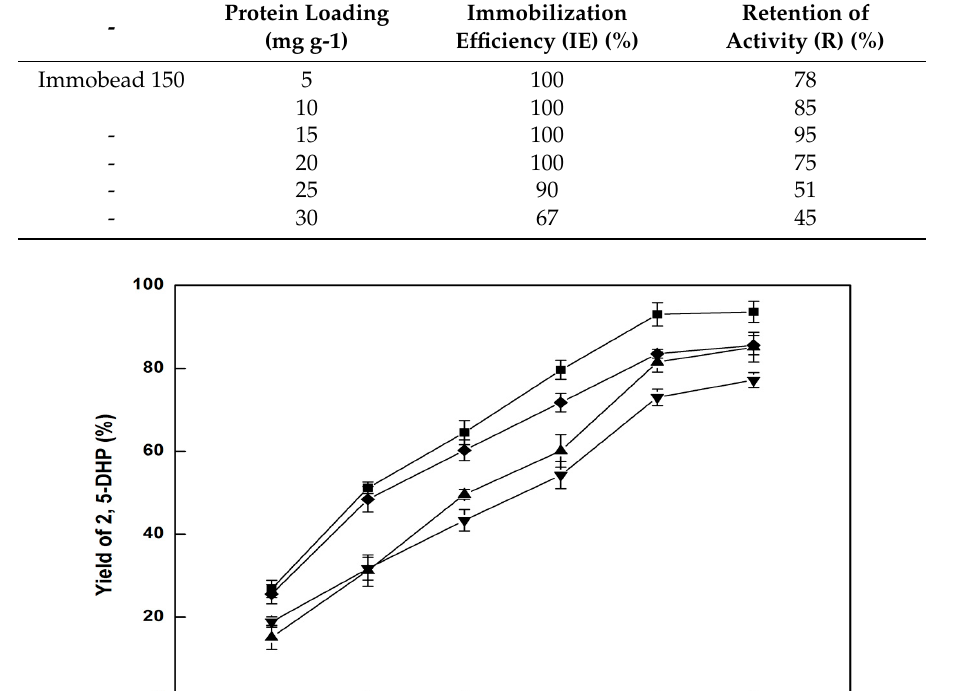
Table 1. Effect of the protein to support ratio (protein loading) on the immobilization of purified HSPHZZ on Immobead 150.